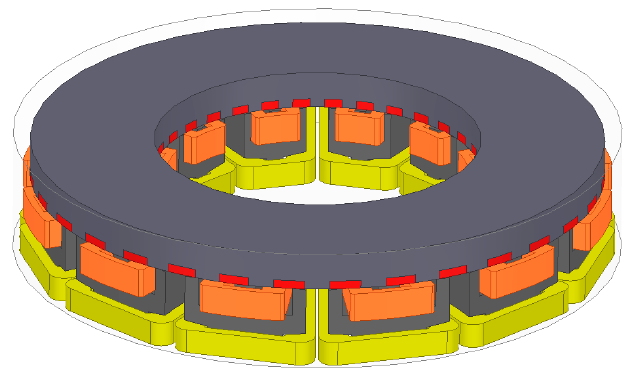
Figure 3. 3-D FEM model of the proposed DR-HEAFPMVM. Table 1. Specifications of the proposed DR-HEAFPMVMs.